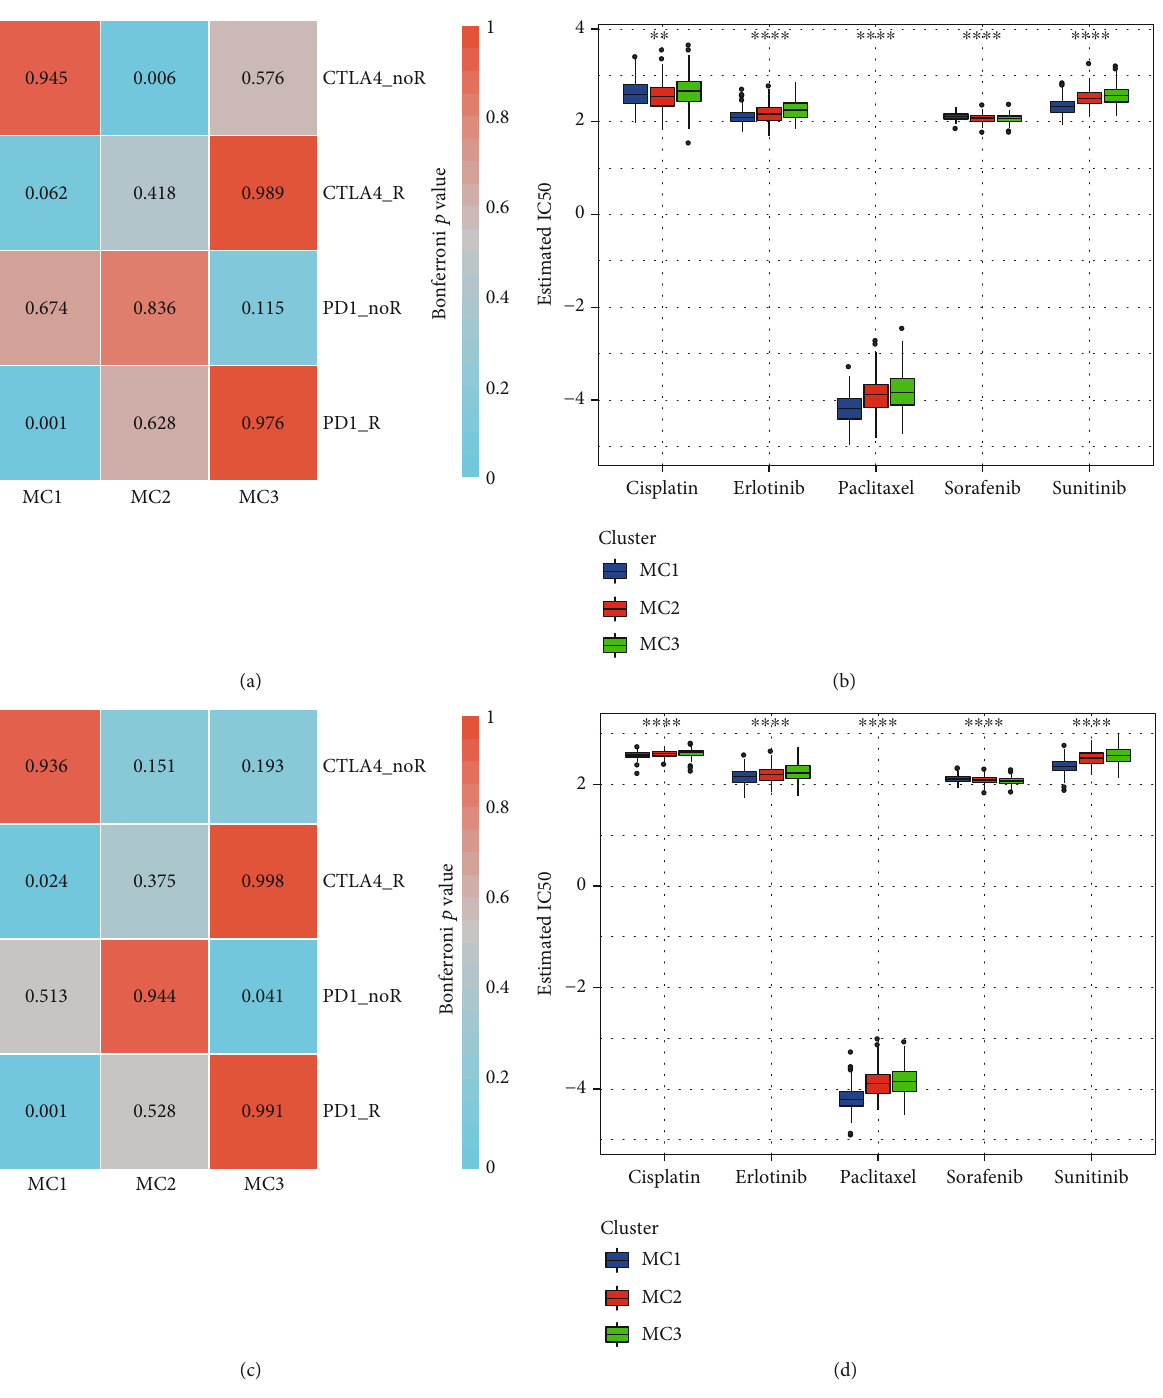
Figure 7: (a) SubMap analysis in RNASeq cohort shows that MC1 is more sensitive to CTLA4 (Bonferroni-corrected P < 0 : 05 ). (b) Box plots of the estimated IC50 in RNASeq cohort. (c) SubMap analysis in GSE cohort shows that MC1 is more sensitive to CTLA4 (Bonferroni-corrected P < 0 : 05 ). (d) Box plots of the estimated IC50 in GSE cohort. noR and R indicate no response and responsive to immunotherapy, respectively. ANOVA test was conducted in (b) and (d). ∗∗ P < 0 : 01 and ∗∗∗∗ P < 0 : 0001